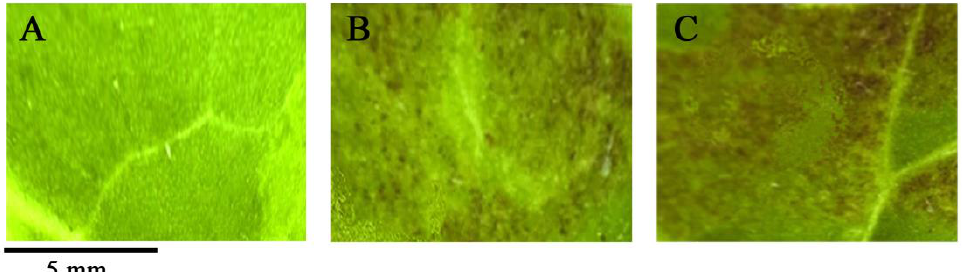
Figure 6. Transient transformation assays identify the activity of AaMYB1 for anthocyanin biosyn- thesis. ( A ), A representative Nicotiana benthamiana leaves image infiltrated with empty vector by transient transformation assays. ( B ), Patches of anthocyanin production in Nicotiana benthamiana leaves by AaMYB1. ( C ), Patches of anthocyanin production in Nicotiana benthamiana leaves by combination of AaMYB1 with AtTT8.